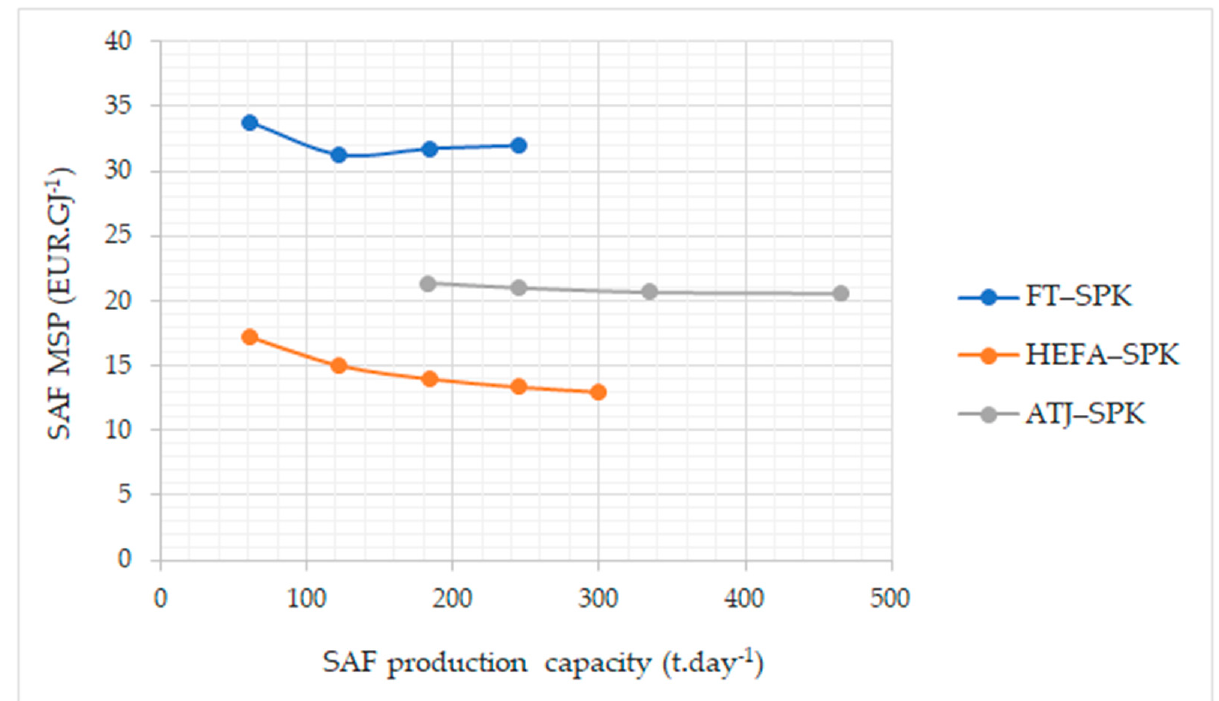
Figure 6. SAF’s MSP as a function of its production capacity.